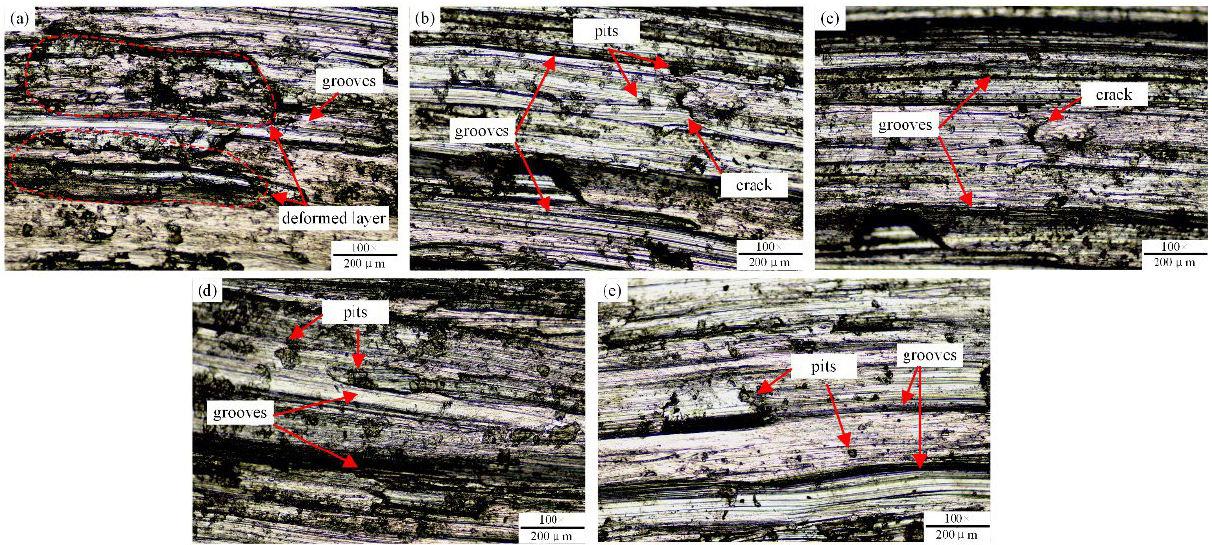
Figure 11. Microscopic morphology of the wear track of AM alloy. ( a ) Specimen-0, ( b ) Specimen-1, ( c ) Specimen-2, ( d ) Specimen-3, ( e ) Specimen-4.